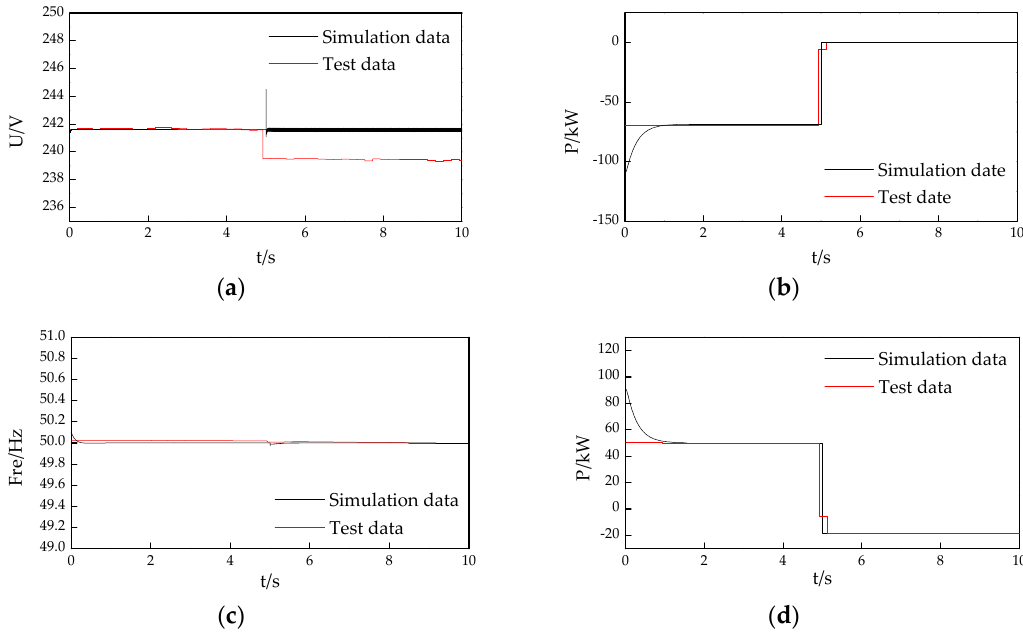
Figure 10. ( a ) Comparison of the voltage at PCC; ( b ) Comparison of the active power at PCC; ( c ) Comparison of the frequency at PCC; ( d ) Comparison of the active power of energy storage unit.